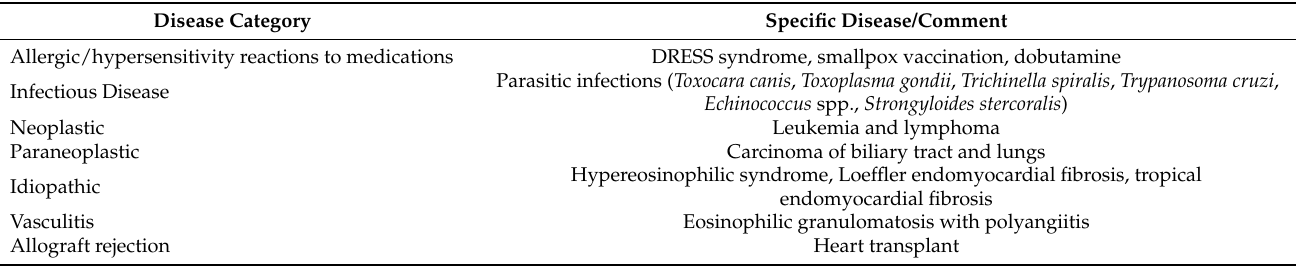
Table 5. The differential diagnosis for patients presenting with fever, eosinophilia, and evidence of cardiac involvement (either by symptoms and/or evidenced by an abnormality in electrocardiogram, cardiac enzymes, or